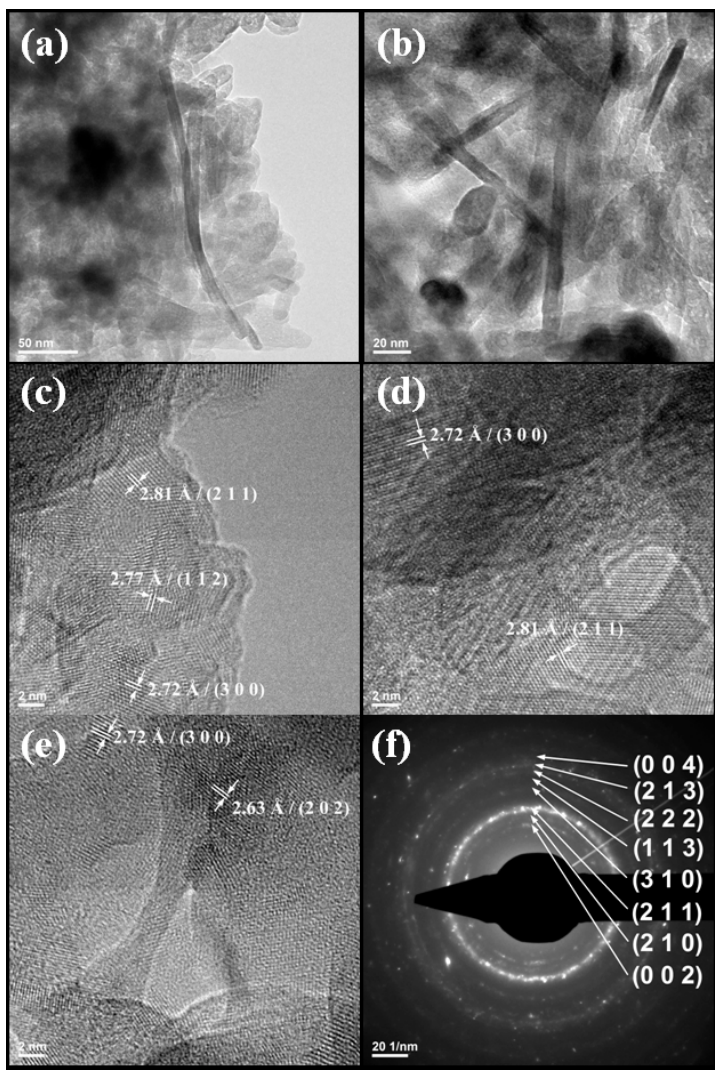
Figure 5. Typical TEM images of 3D-1:1 ( a , b ); HR-TEM images of 3D-1:1 ( c – e ); Selected area electron diffraction (SAED) pattern of 3D-1:1 ( f ).